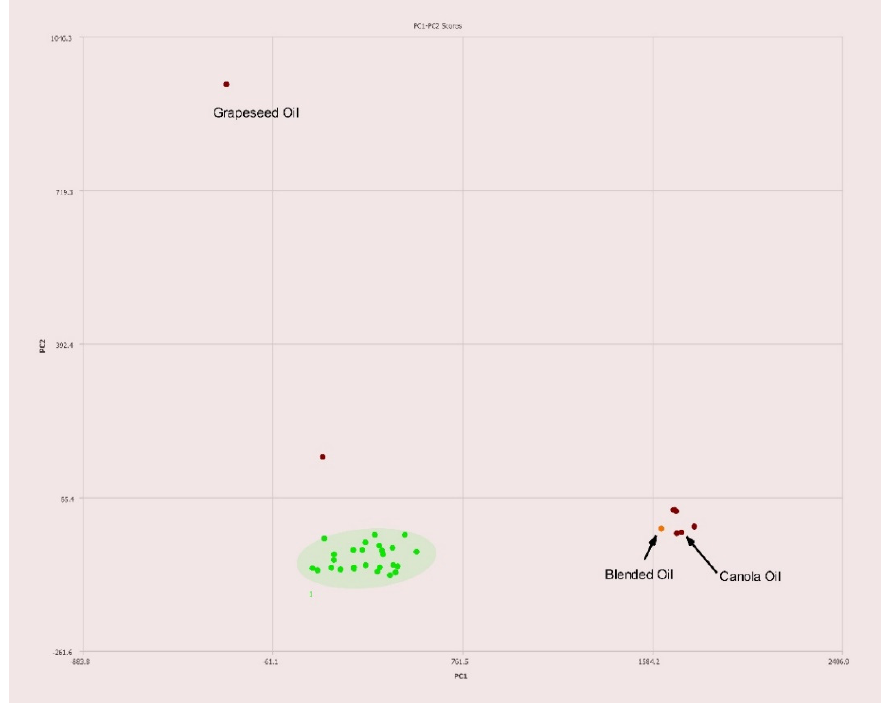
Figure 11. PC1–PC2 plot of 400 MHz 1 H NMR spectra of a commercially available blended oil composed of 70% canola, 20% grapeseed, and 10% olive oils ( v / v ). Ellipses represent the 95% confidence interval.